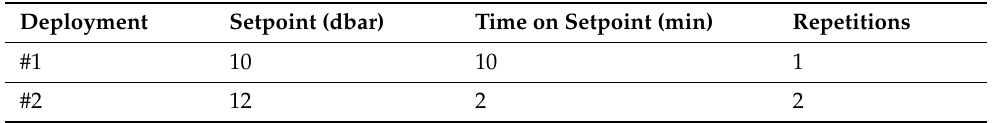
Table 4. Deployment parameter